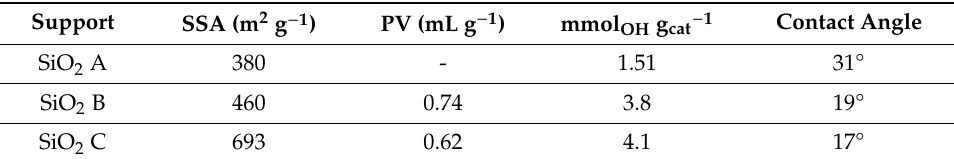
Table 1. Textural properties of silicas used as